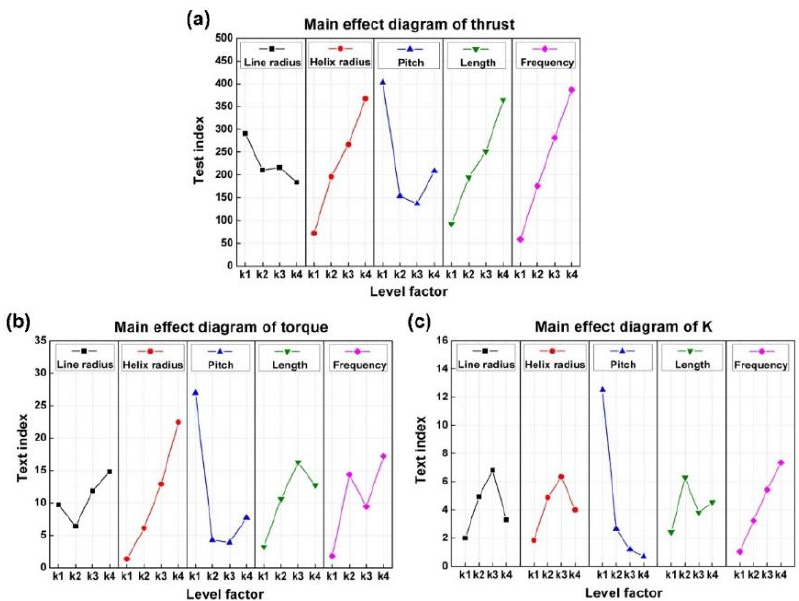
Figure 4. Main effect diagram of three propulsion performance indexes (The detailed data of Figure 4 are shown in Tables A3–A5). ( a ) Thrust. ( b ) Torque. ( c ) K . Line radius, helix radius, pitch, length, and frequency are presented by the black line, red line, blue line, green line, and pink line, respectively.